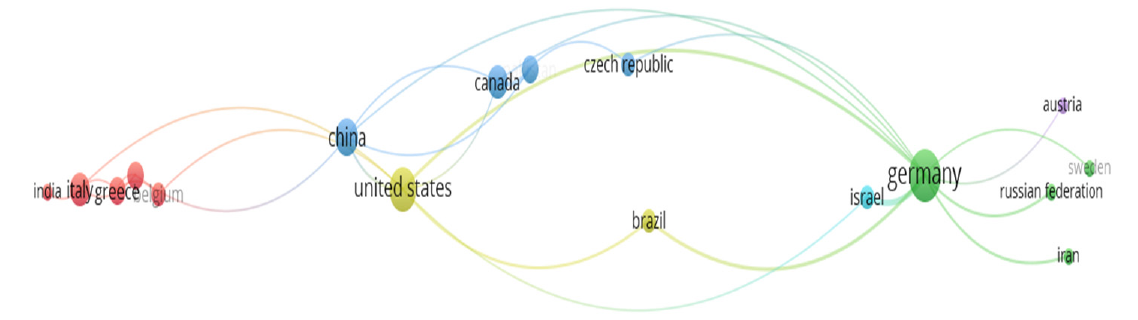
Figure 6. Science mapping of active countries in TRC.